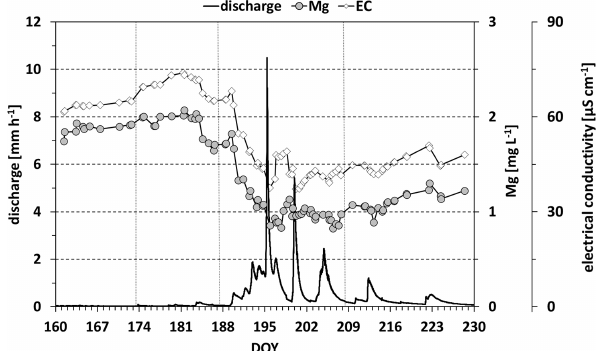
Figure 3. Time series of discharge and of electrical conductivity and magnesium in streamflow. Vertical dashed gray lines separate the four monsoon periods (see also Fig.